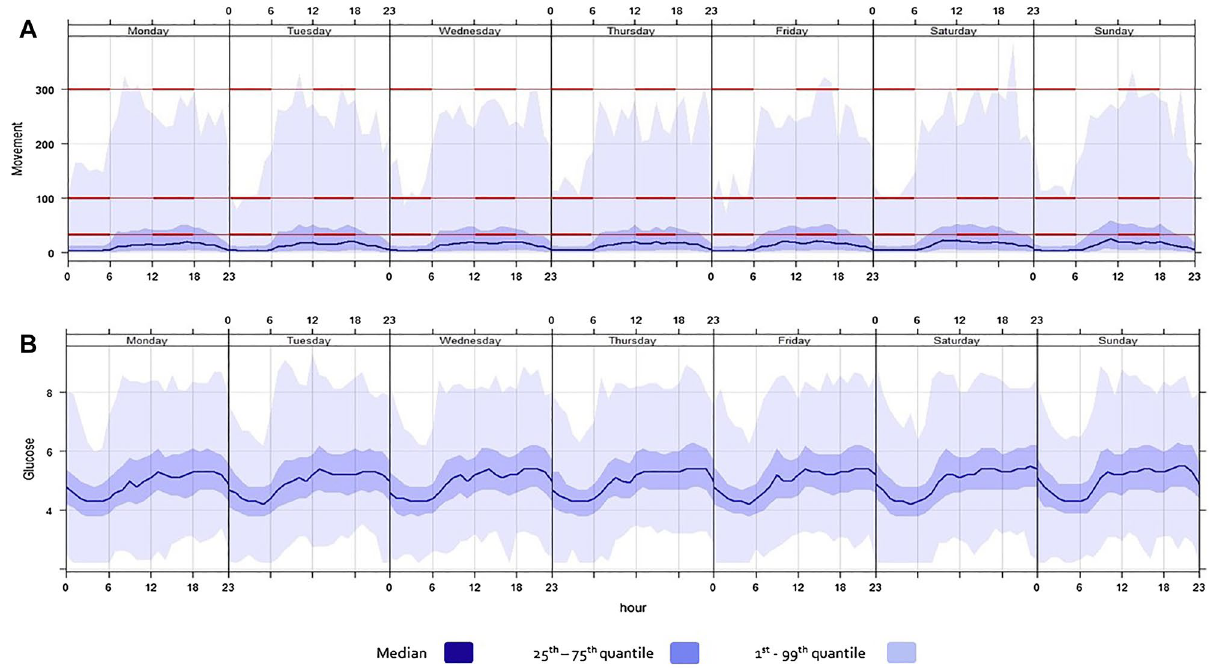
Figure 1. Timeseries of blood glucose and movement: Timeseries of the study cohort—movement and blood glucose values summarised by quantiles: ( A ) Movement (mg) and ( B ) Glucose (mmol/l), exhibiting the diurnal pattern of the entire time series summarised into one week. Nocturnal quantiles of movement and glucose < daytime quantiles. The red lines indicate thresholds for movement intensity. Movement < 30 mg was classed as inactivity (sitting), light intensity movement is ≥30 mg and < 100 mg (slow walks, 3 km/h), moderate intensity movement is ≥ 100 mg and < 400 mg (fast walks, 5 km/h). Vigorous intensity movement ≥400 mg (running, 8 km/h) < 1 quantile of total movement.